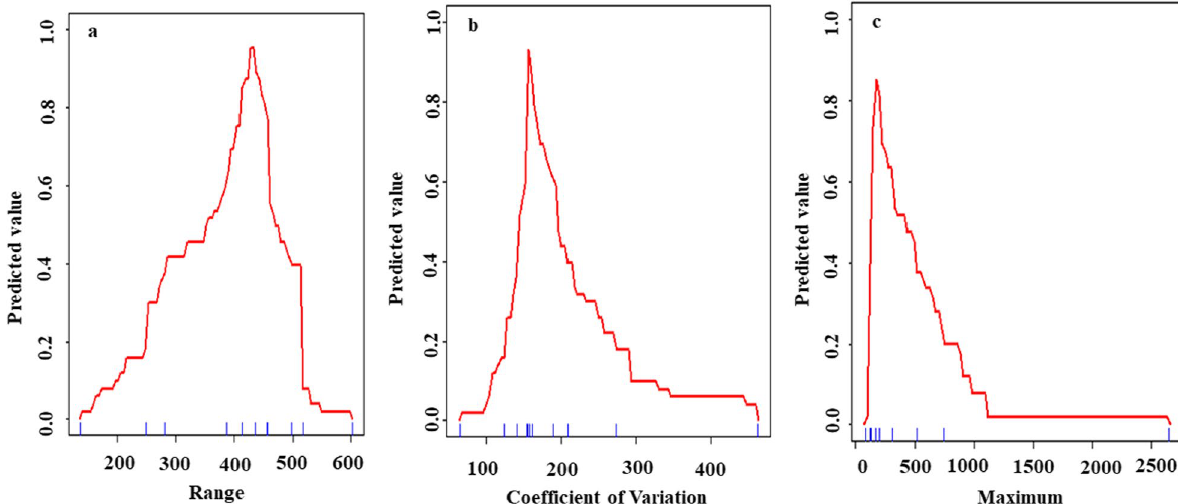
Fig. 9 Receiver operating characteristics curve (ROC) illustrating relationship between probability of occurrence of suitable conditions for distribution of C. wightii with most significant habitat heterogeneity predictors like range ( a ) coefficient of variation ( b ) and maxium ( c )